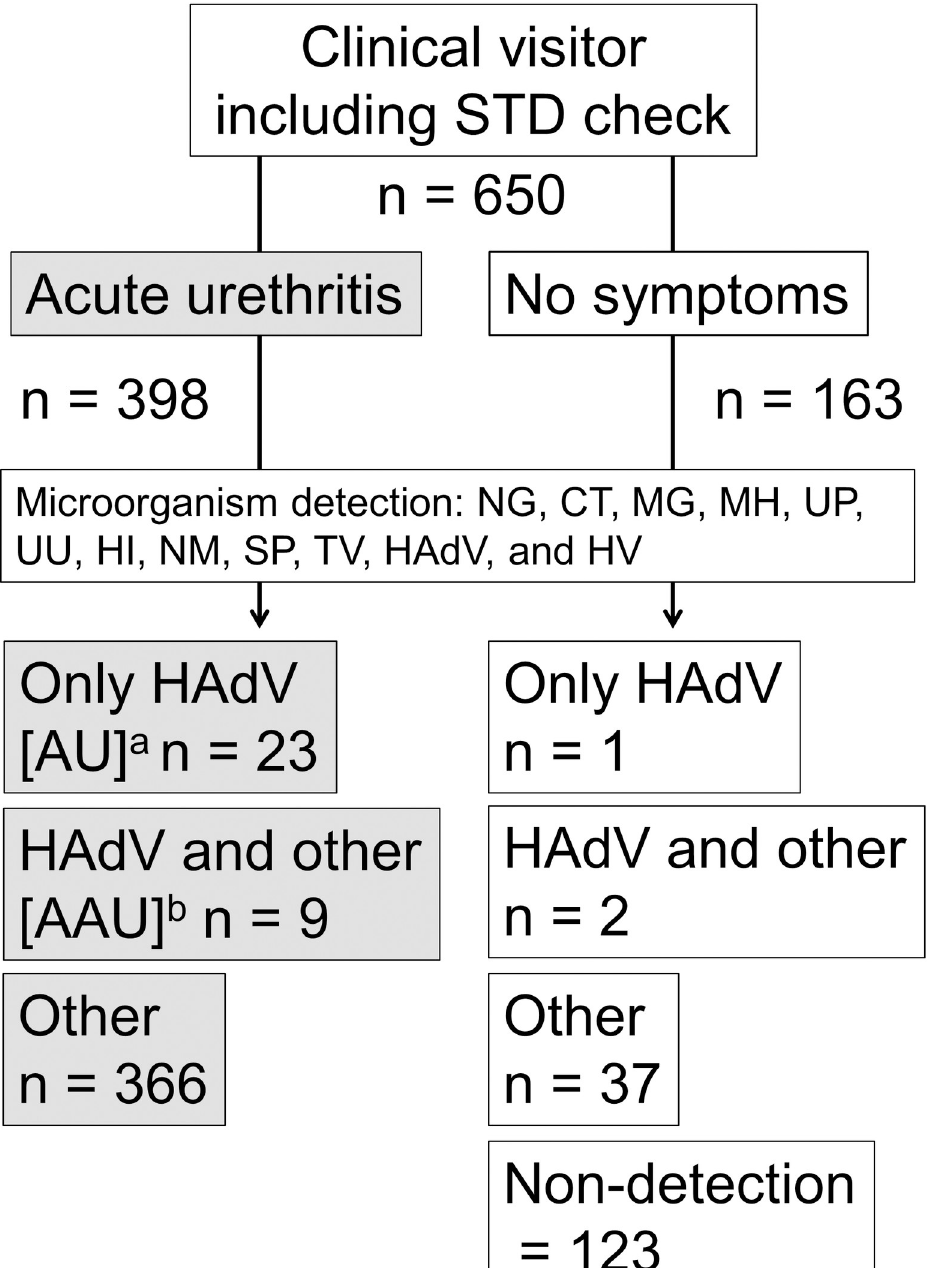
Fig 1. Comparative study flow diagram. A total of 650 clinical visitors were enrolled in this study. They were categorized into two groups. The acute urethritis group included 398 cases, and the no symptoms (asymptomatic) group included 163 individuals. FVU was used for all tests. All specimens underwent screening for the following microorganisms: NG, CT, MG, MH, UP, UU, HI, NM, SP, TV, HAdVs, and HSV. a The 23 cases in which only HAdV DNA was detected were confirmed as adenoviral urethritis (AU) cases and b the nine cases in which HAdV DNA and other pathogens were simultaneously detected were considered as adenovirus-associated urethritis (AAU) cases. A total of 32 cases were confirmed as urethritis with adenovirus in the acute urethritis group. Among the 163 individuals in the asymptomatic group, only one case was positive for HAdV DNA alone and two cases simultaneously had both HAdV DNA and other pathogens. Other pathogens were detected in 37 FVU samples, and 124 patients exhibited no pathogens in urine. Abbreviations: NG, Neisseria gonorrhoeae; CT, Chlamydia trachomatis; MG, Mycoplasma genitalium; MH, Mycoplasma hominis, UP, Ureaplasma parvum; UU, Ureaplasma urealyticum; HI, Haemophilus